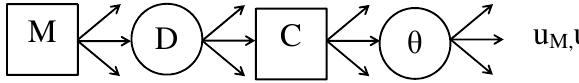
Figure 10. Game tree for the adversarial life testing